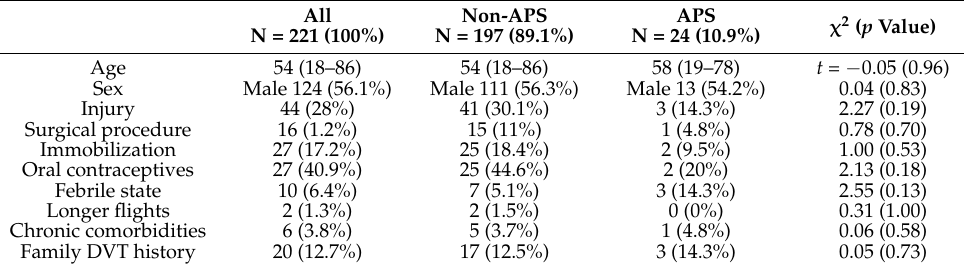
Table 1. Demoraphic and risk factor analysis of included deep vein thrombosis (DVT) patients. Results are expressed as median (range) for age, and counts (%) for sex and risk factors. Independent samples t -test was used for age, χ 2 test was used for other